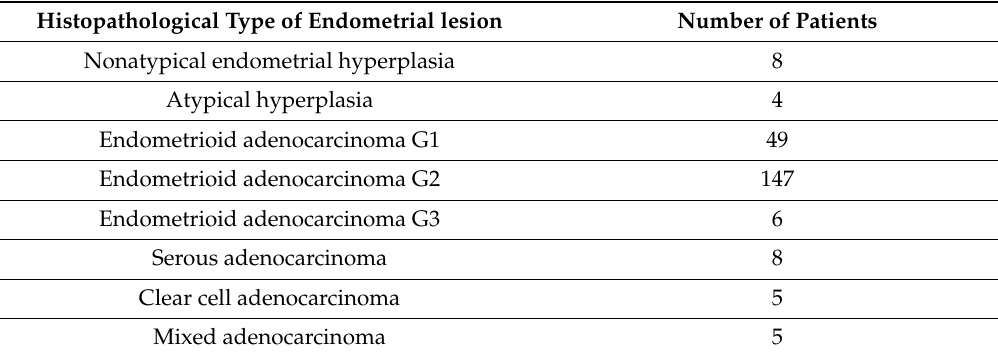
Table 4. Number of patients with different histopathological types of endometrial lesions. Histopathological Type of Endometrial lesion Number of Patients Nonatypical endometrial